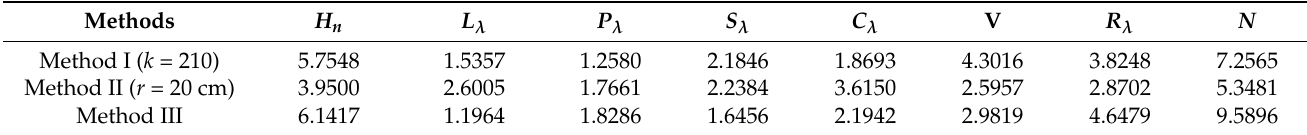
Table 2. Feature importance values derived from Random Forest classifier.